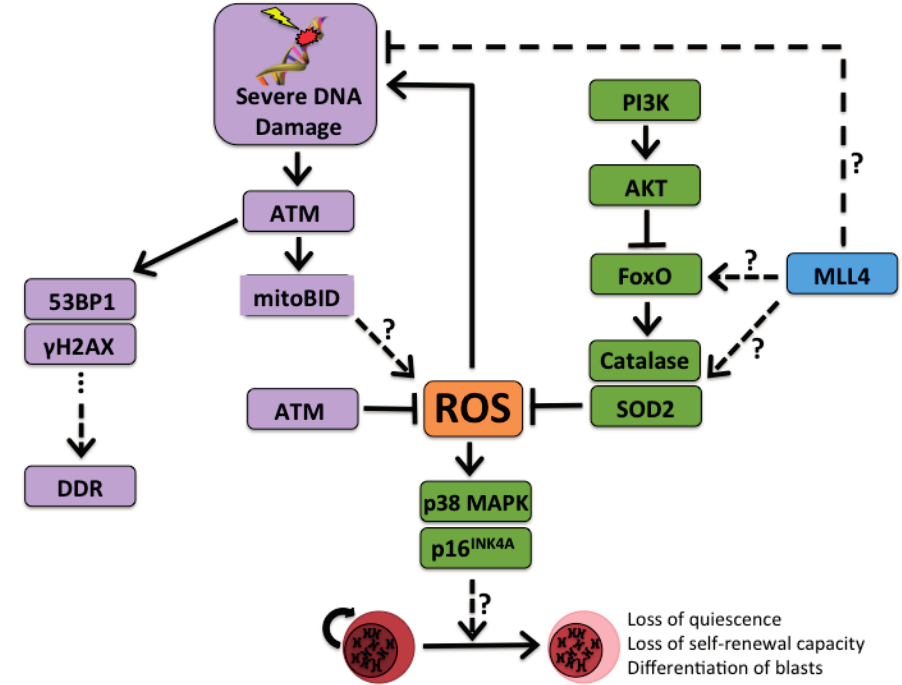
Figure 1. The ROS rheostat of hematopoietic stem cell (HSC) maintenance.